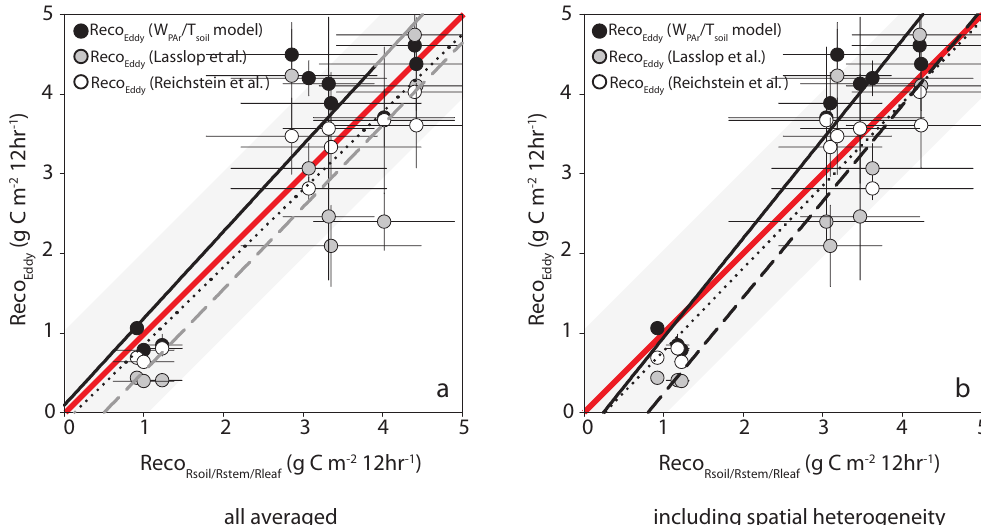
Fig. 8. Total carbon loss (gCm − 2 ) during 12 daytime hours (6a.m.–6p.m.) for each plot during the different seasons (wet season = high values, dry season = smaller values). Three different approaches were used to calculate daytime ecosystem respiration from eddy covariance data: (1) (black dots, black solid regression) a model, including the response of R eco to relative plant available water (0–100m) and soil temperature (5cm depth) parameterized biweekly from high quality nocturnal data; (2) (grey dots, grey solid regression) a model recently developed by Lasslop et al. (2009); (3) (white dots, black dotted regression) were values of R eco received from a gapfilling – and fluxpartitioning tool (Reichstein et al., 2003). Two different methods were used for the bottom-up approach (a) averaging all measurements of soil- and leaf respiration plus the calculated values of stem respiration and (b) accounting for spatial heterogeneity by the categorized soil CO 2 efflux plus leaf- and stem respiration. All bars are given +/- SD. The red line shows the 1:1 line, the grey highlighted area show the 20% deviation from the 1:1 line. (a) white: r 2 = 0 . 90, p < 0 . 0001, n = 9, y 0 = − 0 . 12, a = 0.97 grey: r 2 = 0 . 7, p = 0 . 001, n = 9, y 0 = 0 . 51, a = 1.03 black: r 2 = 0 . 81, p = 0 . 0002, n = 9, y 0 = 0 . 09, a = 1.09 (b) white: r 2 = 0 . 88, p < 0 . 0001, n = 9, y 0 = − 0 . 27, a = 1.03